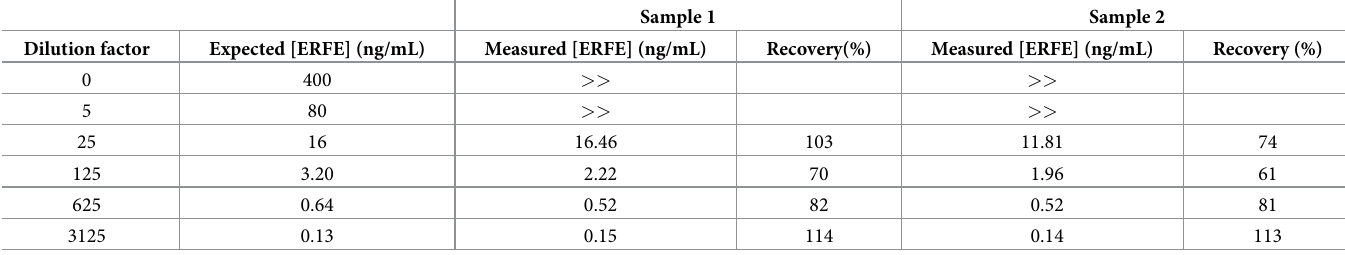
Dilution linearity assessment of ERFE assay in human serum. Two low ERFE containing serum samples were spiked with hERFE to 400 ng/ml and serially diluted. Recovery was calculated as (measured ERFE / expected ERFE) � 100%. Measured ERFE concentrations were not dilution-adjusted. >> represents ERFE concentrations above